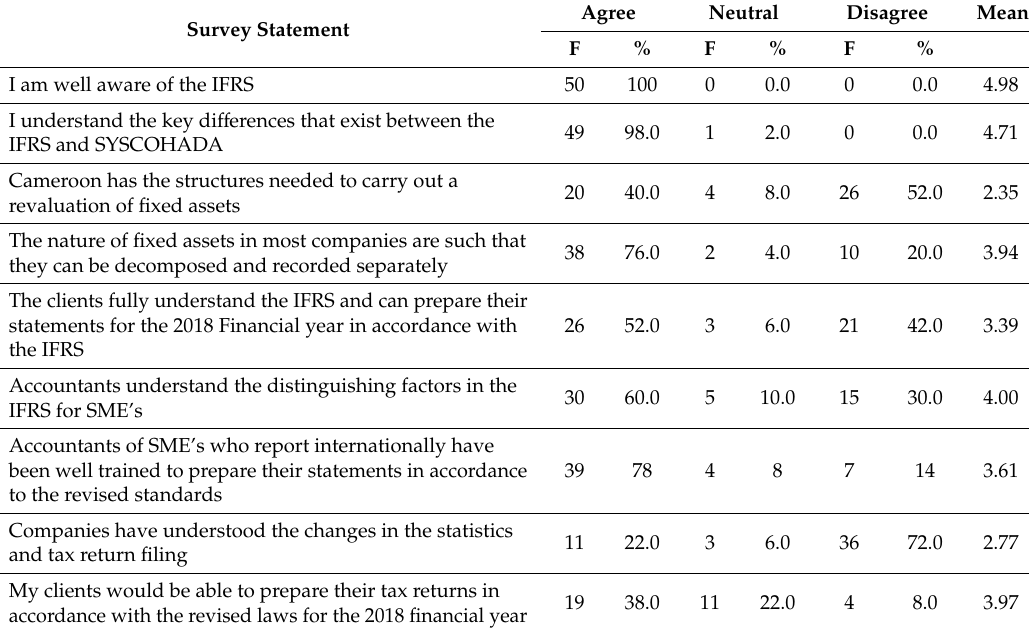
Table 4. Respondents’ view on the extent of the implementation of International Financial Reporting Standards (IFRS) in